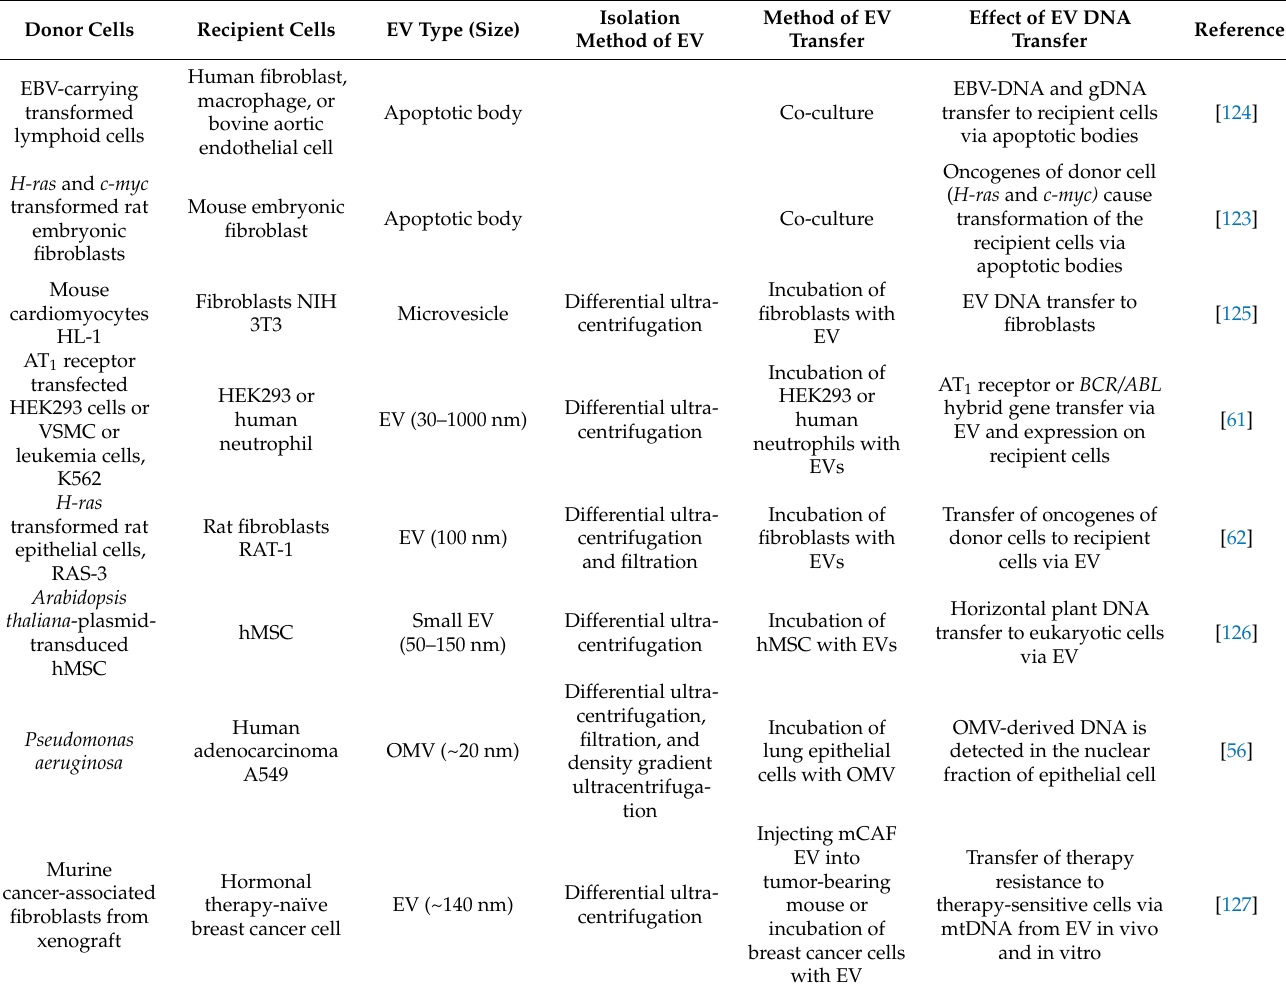
Table 2. Research on the transfer of EV